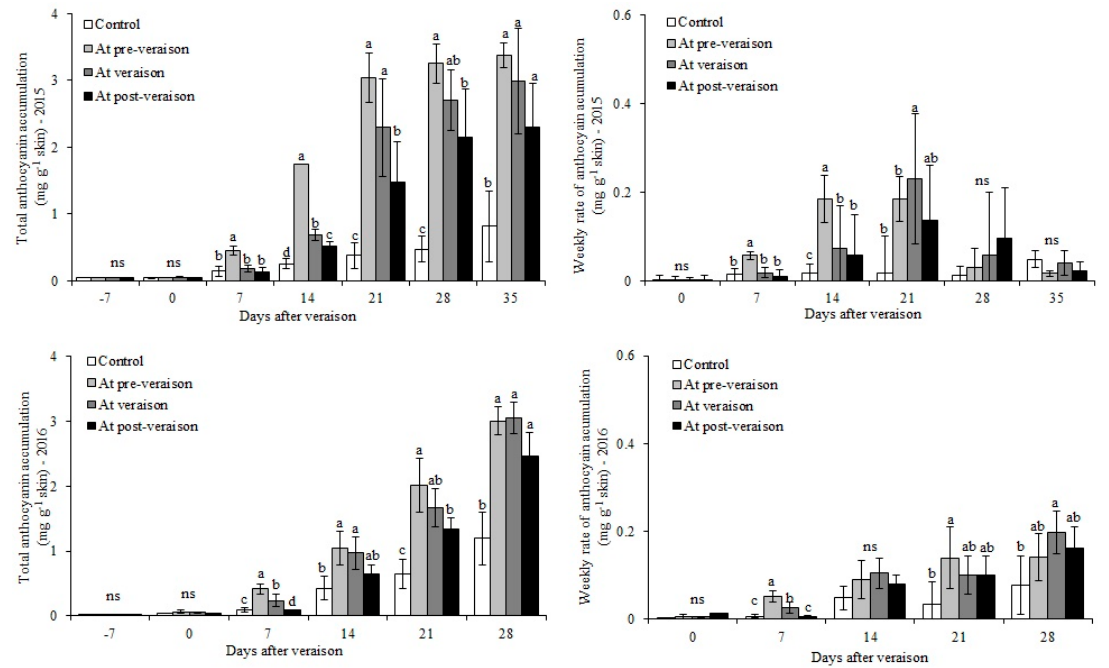
Figure 1. Total anthocyanin accumulation (mg g − 1 of skin) and weekly rate of anthocyanin accumulation (mg g − 1 of skin) of ‘Benitaka’ berries ( Vitis vinifera L.) subjected to ( S )- cis -abscisic acid ( S -ABA 400 mg L − 1 ) at different timings of ripening. A second application of S -ABA 400 mg L − 1 was performed for all treatments 10 days after the first application, except for the control. Means within columns for the same letter followed by different letters differ significantly by Tukey’s test ( p < 0.05). ns: non-significant.